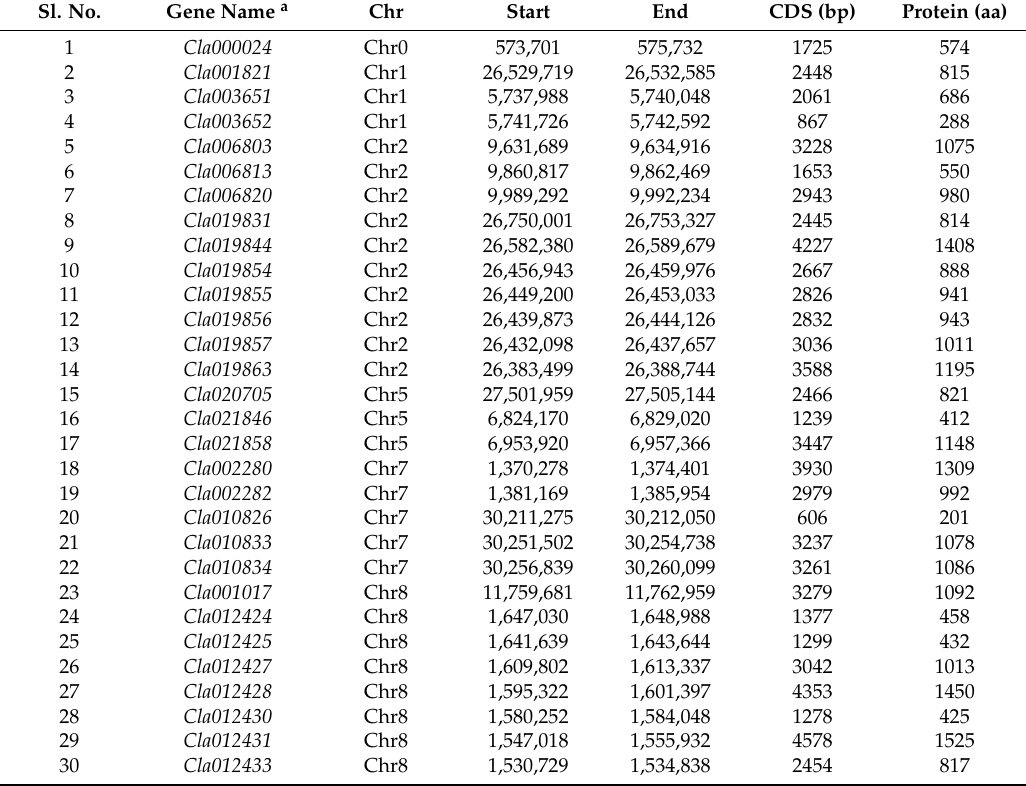
Table 1. Location of 44 NBS-encoding genes on the watermelon